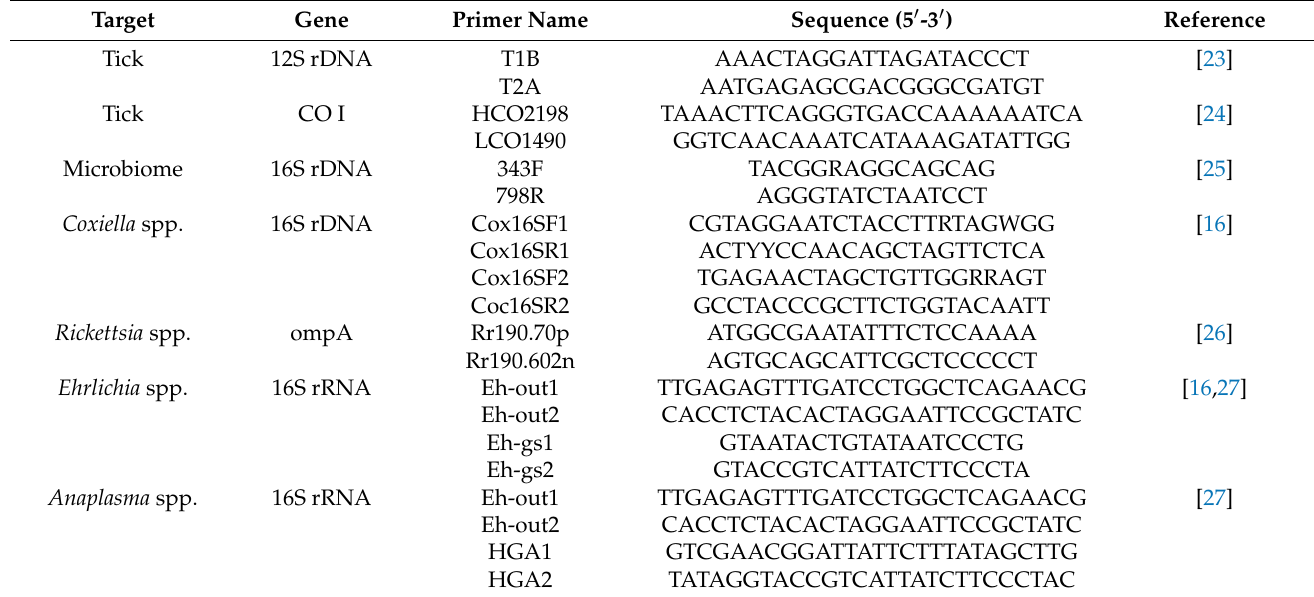
Table 1. Primers used in this